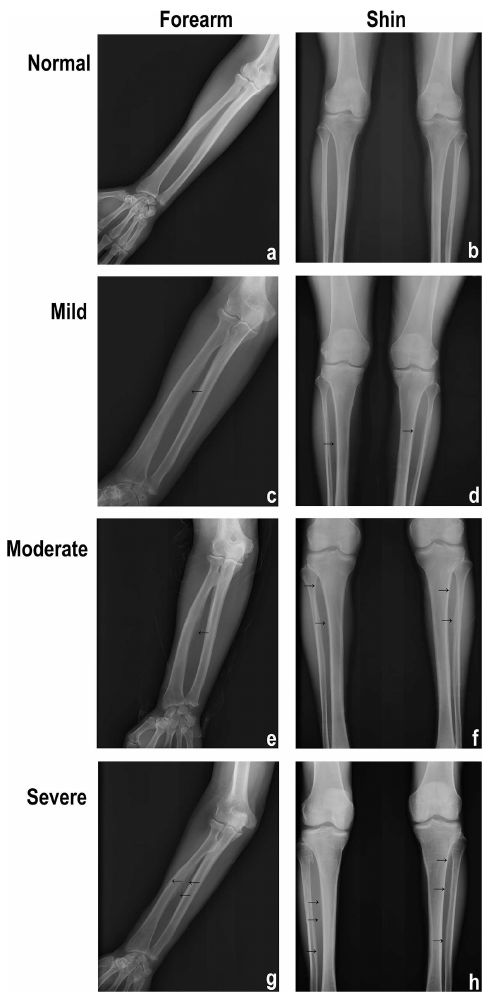
Fig 1. Representative images of brick-tea type skeletalfluorosis by X-ray examination. Normal(a) and (b): Normalforearmandshin. Mild (c) and(d): The interosseousmembrane in the forearmor lowerleg bonewas mildlyossifiedwithroughedges(arrows). Moderate(e) and(f): The radialcrest andthe borderwereenlarged; the interosseousmembrane in the forearmor shinwas ossifiedwith serrationor waveedge(arrows). Severe(g) and(h): The radialcrest was enlargedandthe borderwas obviously enlargedso that ulnaandelbowjoints presented severedegenerative changes;the interosseousmembrane in the forearmor shinwas obviously ossifiedwith